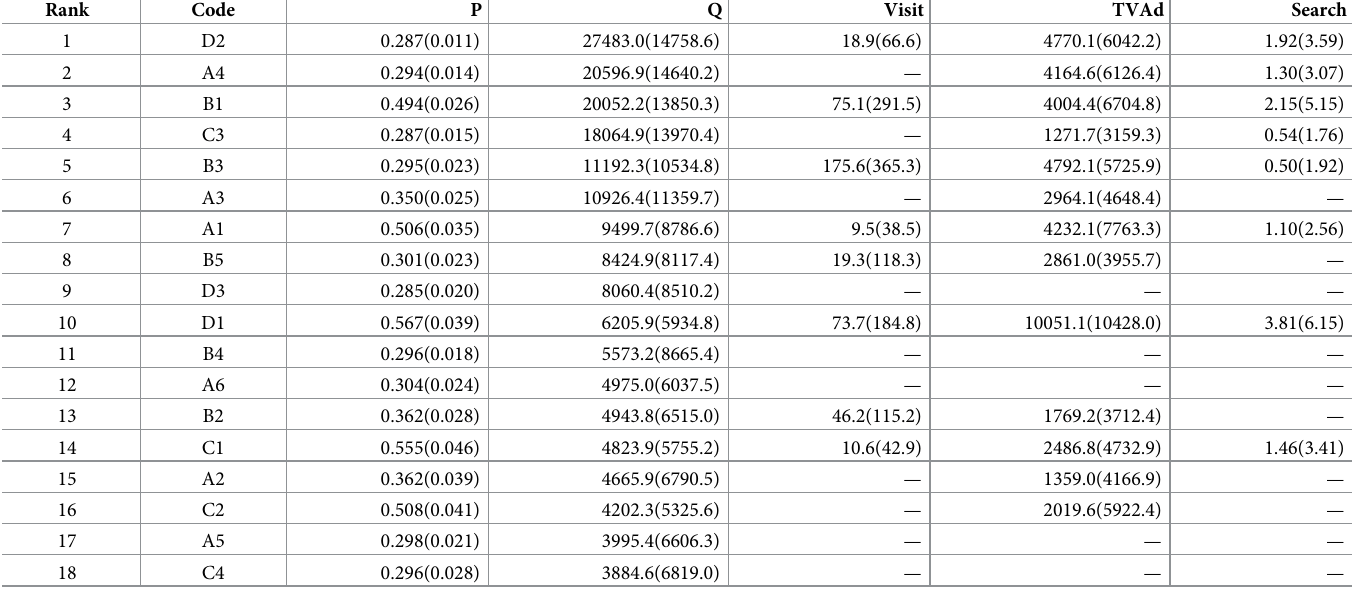
depict, as a sample of ~ x ð t Þ , the five types of time series for the top product “D2” ( α = 1, � � � , 5) a i in Fig 3. Price per unit quantity (P) is mostly stable but has spikes of increasing or decreasing price change. Quantity (Q) has volatility due to growing and sluggish sales. The frequency of site visits via PC or mobile device (Visit) have tranquility with sudden and short activities. The Table 3. Descriptive statistics for the top-selling 18